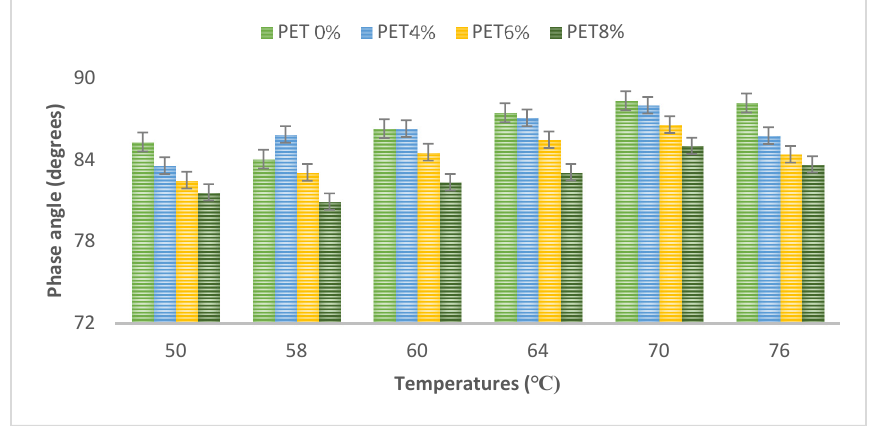
Figure 14. Phase angle results of the PET-modified bitumen.